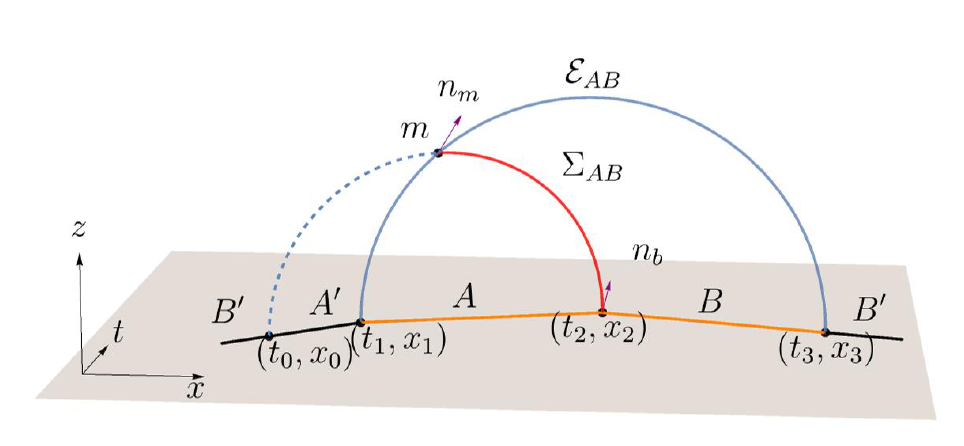
Figure 5: Illustration of EWCS in the adjacent case. The red curve is the EWCS Σ whose extension (the dashed blue line) ends at the balance point ( t n is normal to both the EWCS and E m